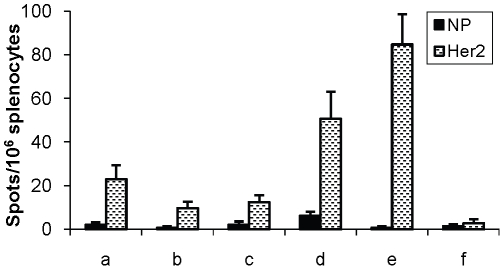
Long-term IFNγ responses after Her2MPtVLP immunization.BALB/c mice were immunized with Her2MPtVLPs with CpG either 10 weeks (a), 6 weeks (b) or 1 week (d) before ELISPOT analysis, or with Her2MPtVLPs without CpG 6 weeks (c) or 1 week (e) before ELISPOT. Unimmunized mice were included as negative controls (f). Splenocytes were stimulated with the immunodominant CD8+ peptide Her263–71 or the control peptide NP118–126. Average values of triplicates from 4 animals are shown. Background values (stimulation in the absence of peptide) have been subtracted. Error bars represent S.E.